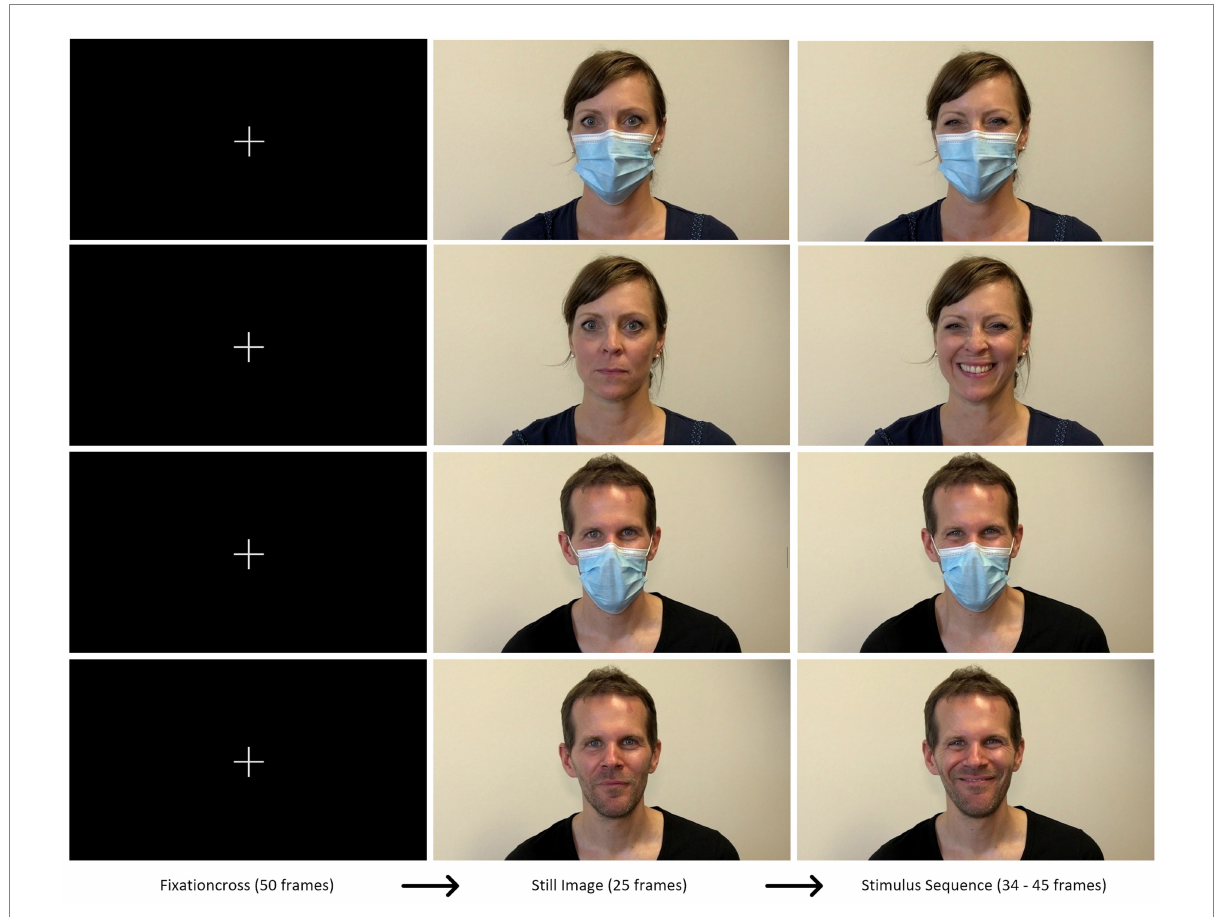
FIGURE 1 Schematic illustration of experimental trials displaying the Duchenne condition from both actors with and without mask.